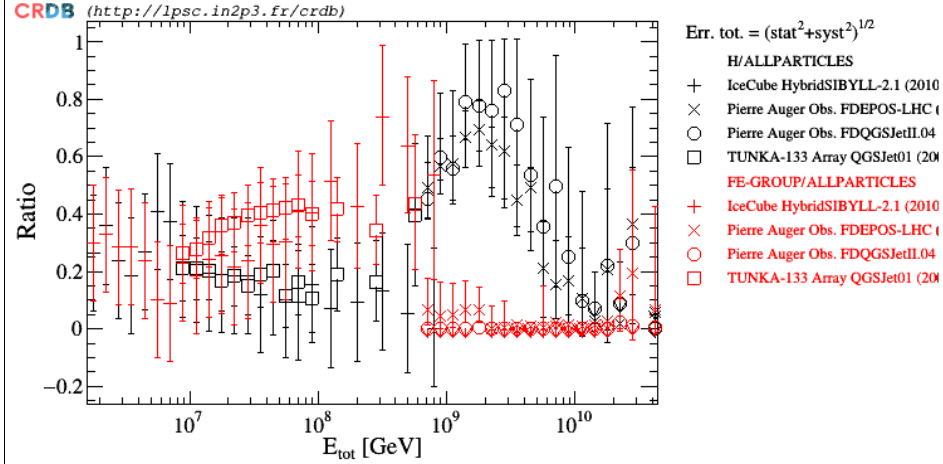
Figure 3. Sample of UHECR (Ultra-high energy cosmic-ray) data added in CRDB v4.0 . For illustration, we show the fraction of light ( H ) and heavy ( Fe-group ) cosmic rays for IceCube [108], Pierre Auger Observatory [109] for two different Monte Carlo event generators, and TUNKA-133 [110]. Note that very long subexp names always get truncated in CRDB displays (as seen in the